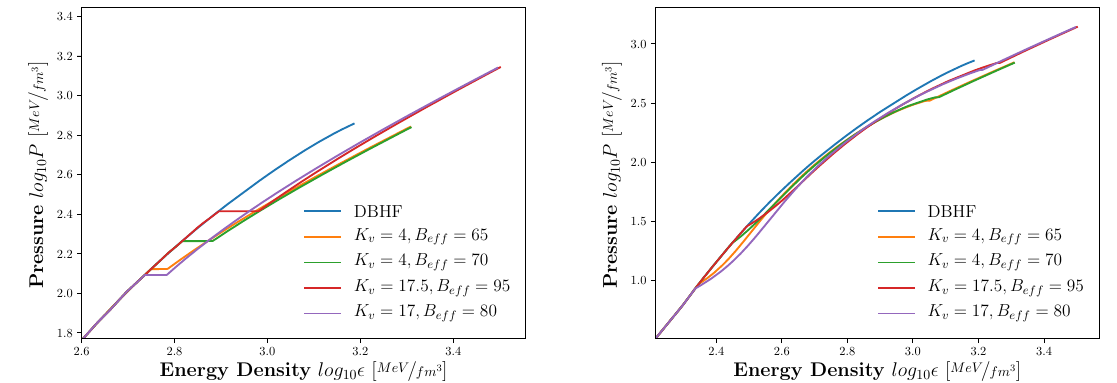
Figure 1. Equation of State Curves with Phase Transitions Nuclear Matter. The DBHF curve is the purely (cid:2) (cid:3) nuclear model, while the curves denoted with K v GeV − 2 and B eff [ MeV / fm 3 ] values are the hybrid models that experience transitions from nuclear to quark matter. The image to the left displays hybrid configurations with a Maxwell construction, and the image to the right illustrates these same configurations with Gibbs configurations. While the images focus on the location of the phase transition in each respective model, these models continue to follow the same profile referenced in [30] down to pressure and density regimes typical of atmospheric